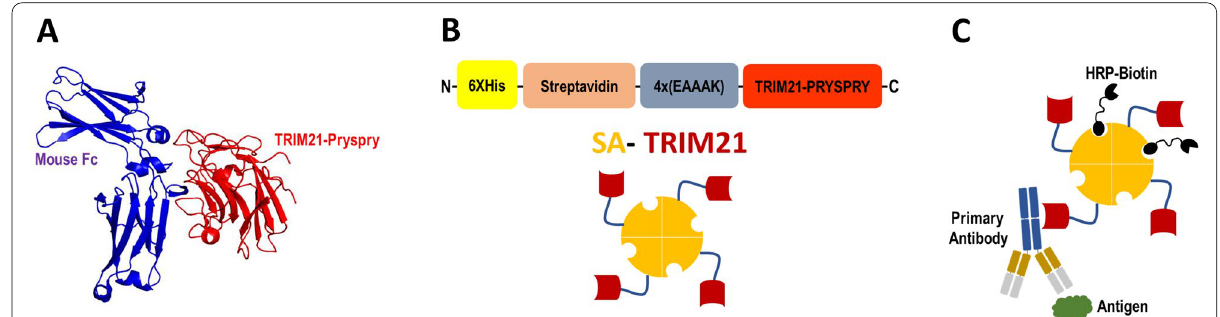
Fig. 1 Schematic diagram showing chimeric protein. A A 3D-structure of Mouse IgG (blue) bound to the PRYSPRY domain of wild-type mouse TRIM21 (red). B The primary and quaternary structure of SA-TRIM21. In red is represented the PRYSPRY domain of TRIM21. Purple represented the rigid EAAAK linker, orange shows the streptavidin domain and yellow the Poli-histidine tag. C The graphical summary of SA-TRIM21 recognizing the antigen/antibody complex and performing signaling by biotin-HRP